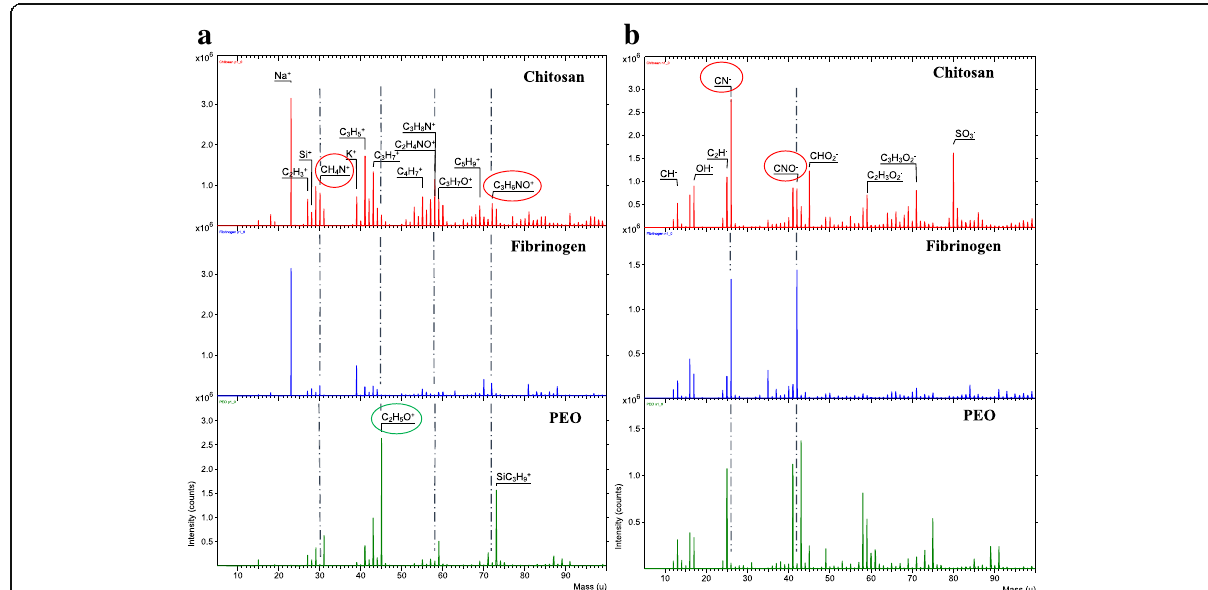
Fig. 3 Representative a positive and b negative ion ToF-SIMS spectra for pristine CS (top), Fb (middle), and PEO (bottom). Circled ion fragments were utilized as the unique fingerprint to identify the